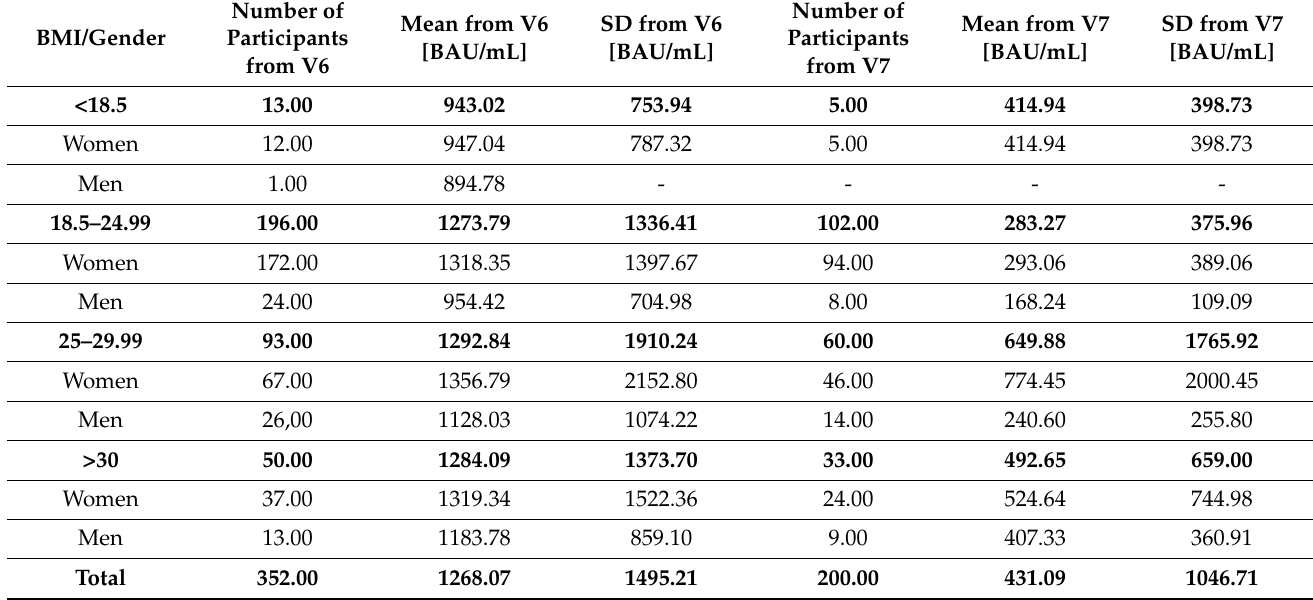
Table 4. Antibody concentrations in the gender structure in relation to BMI.